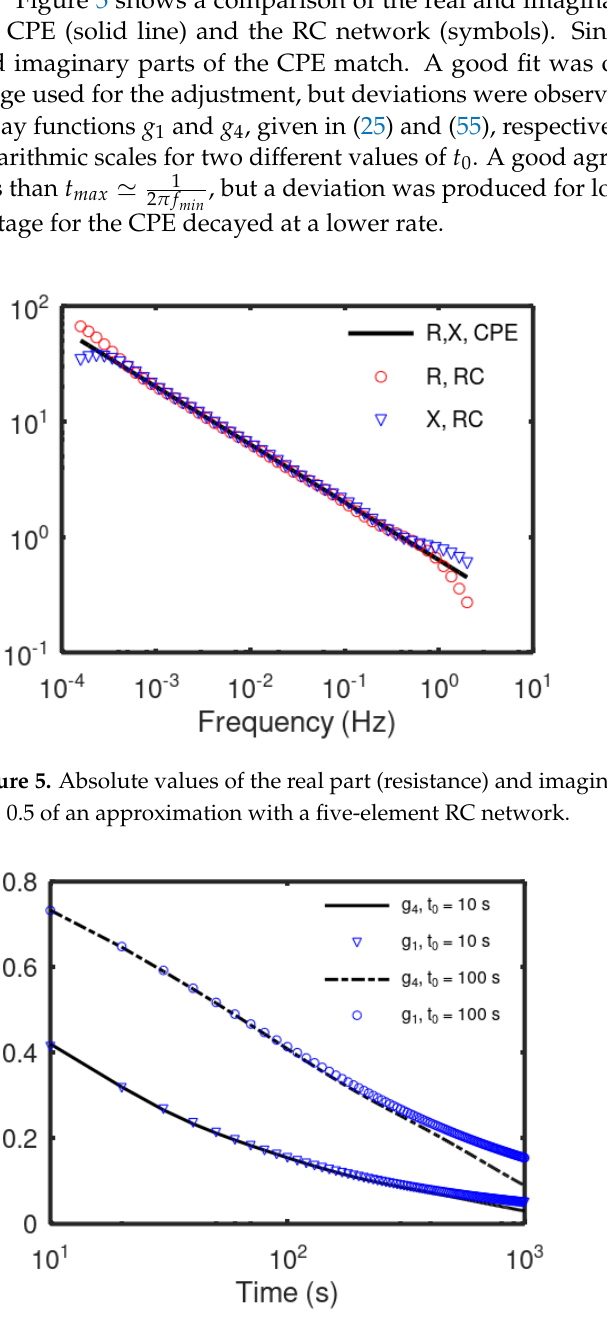
Figure 6. Decay function of the initial voltage obtained by applying a constant current to a CPE with α = 0.5 and to an approximation with a five-element RC